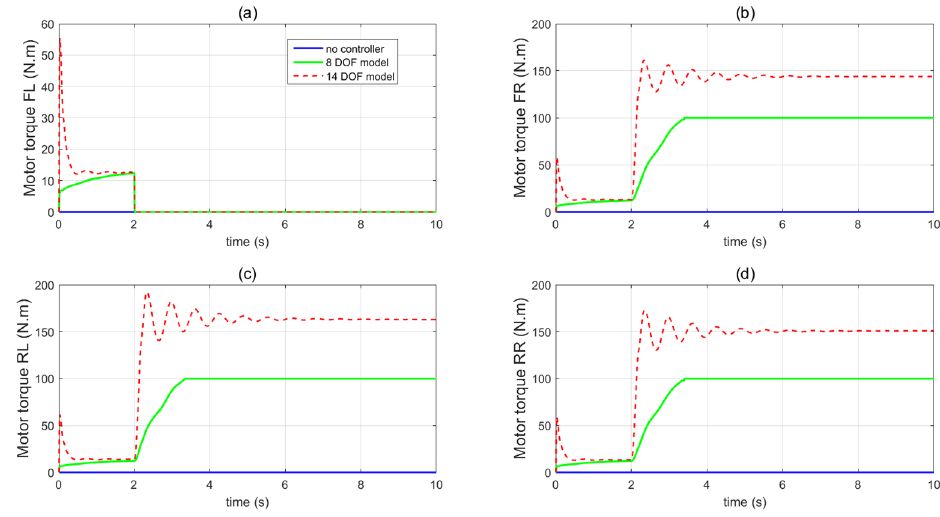
Figure 11. Vehicle motor control inputs in the first set of simulations ( a ) front left wheel, ( b ) front right wheel, ( c ) rear left wheel, ( d ) rear right wheel.